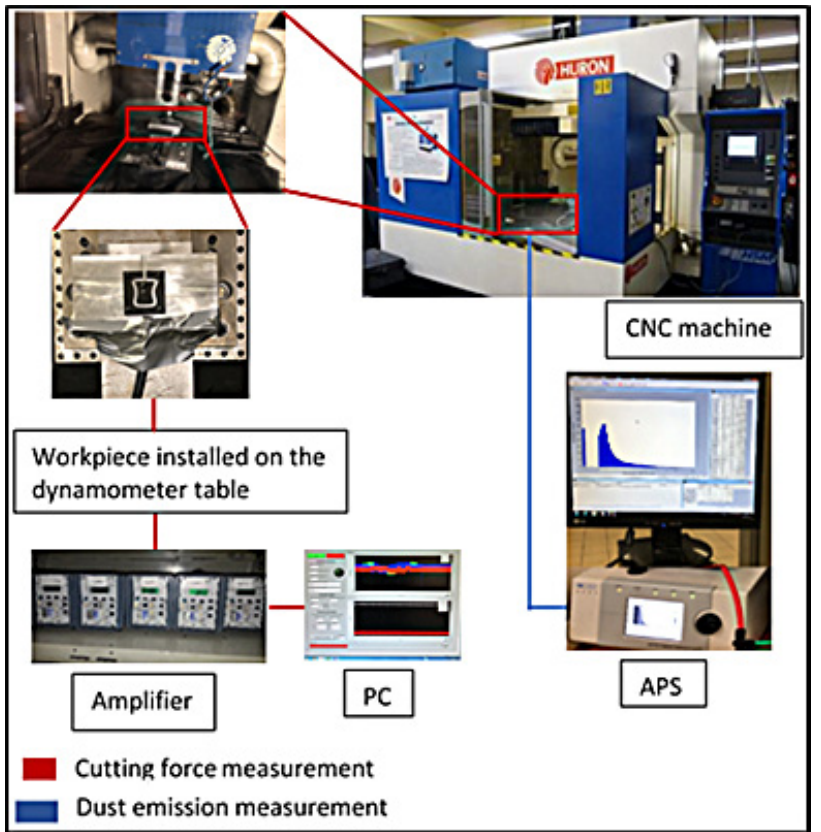
Figure 1. Photographs showing setup for machining CFRP and measurement system, and shape and geometrical dimensions of workpiece used in this study.